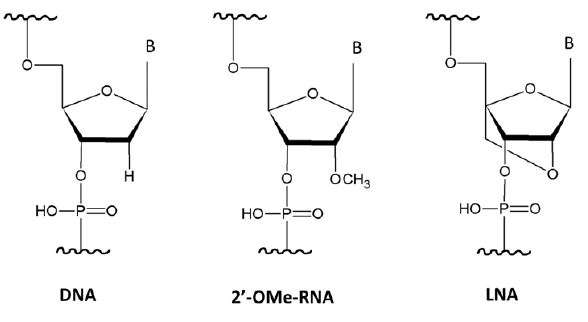
Figure 1: Scheme of chemical structures of DNA nucleotide and its analogous 2’-OMe-RNA and